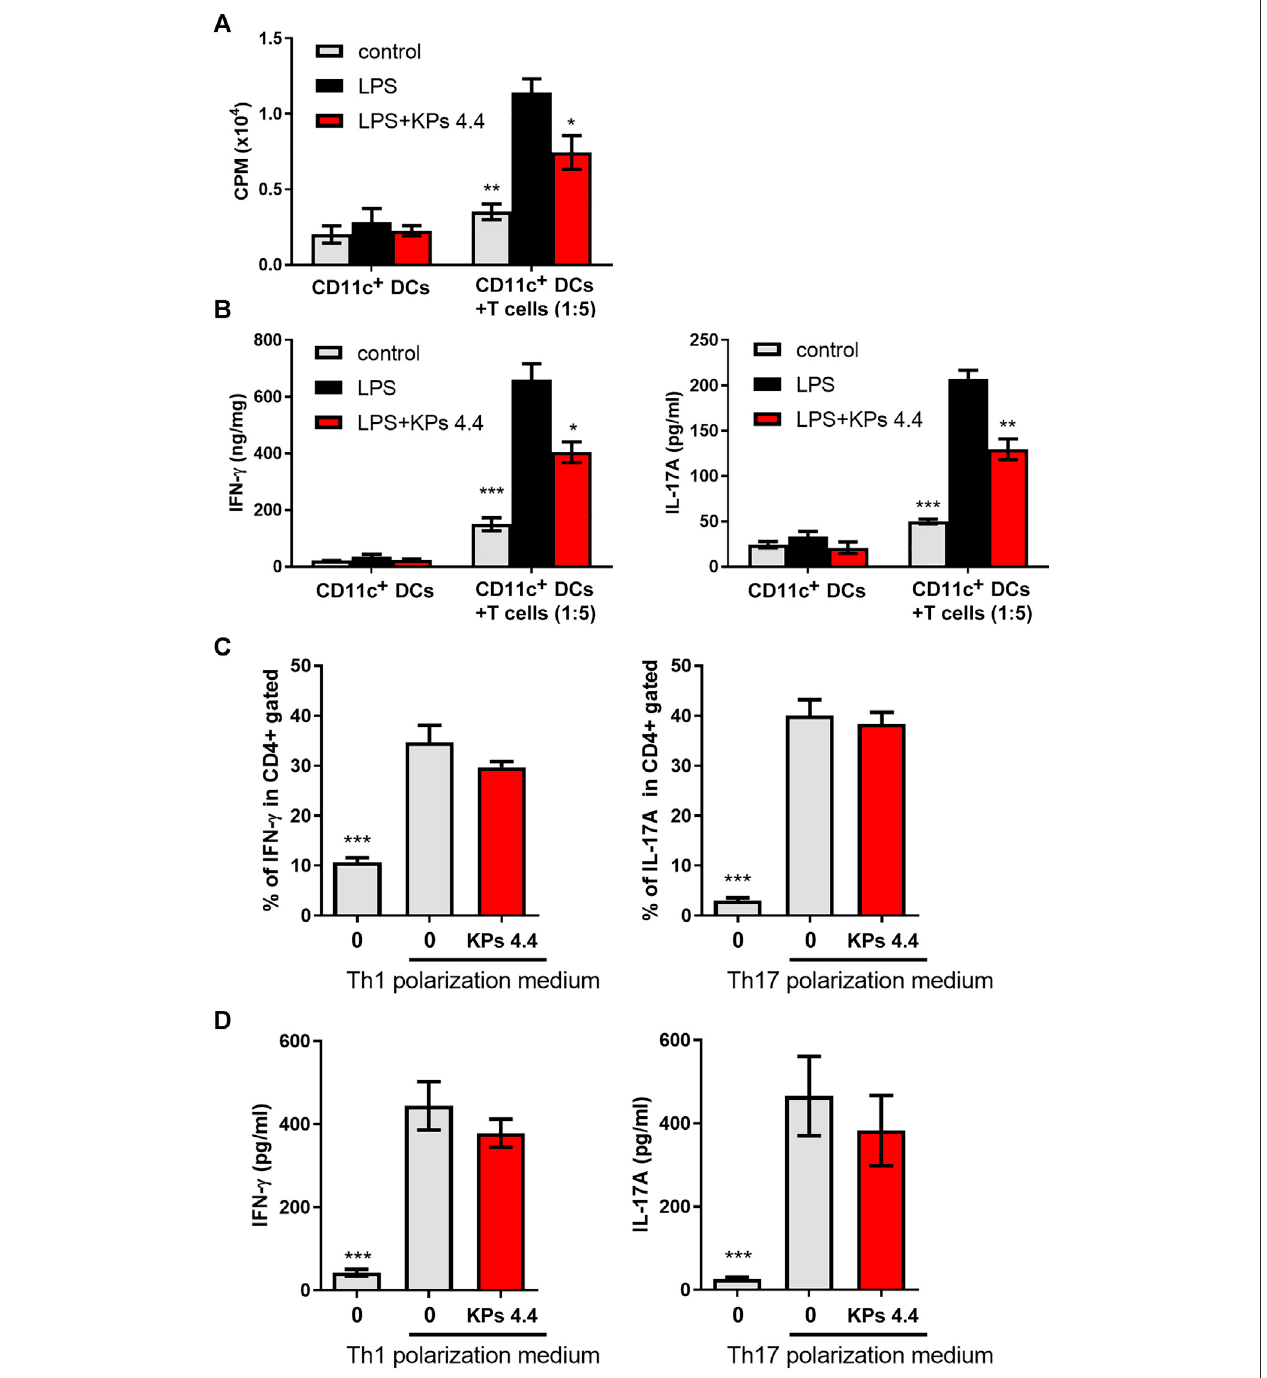
FIGURE 2 | Effects of KPs on CD4 + T cells proliferation, LPS-stimulated BMDC cytokine production in vitro , and Th1 and Th17 differentiation in vitro . (A) OT-II- speci fi c CD4 + T cells were cocultured with BMDCs in the presence of OVA and LPS. KPs were added at a concentration of 4.4 mg/ml at the beginning of the induction. After3 daysofculture,thechangesinTcellproliferationviathe 3 H-TdRincorporationassaywerequanti fi edincountsperminute(CPM)byliquidscintillationcounting. (B) The levels ofIFN- γ and IL1-7A inthesupernatantsofthe cocultures. The valuesare presented asthemean ± SEM(n (cid:1) 3). * p < 0.05;** p < 0.01; *** p < 0.001vs the LPSalonegroup,asdeterminedbyone-wayANOVAwithDunnett ’ stest. (C) NaïveCD4 + TcellswereculturedinTh1-orTh17-polarizingconditionedmedium.KPswere added at a concentration of 4.4 mg/ml at the beginning of induction. Bar graphs showing the percentages of CD4 + T cells expressing IFN- γ and IL-17A, as determined by fl owcytometry. (D) ThelevelsofIFN- γ and IL-17Aproduced underTh1-orTh17-polarizing conditions wereexaminedwithELISAkits. Thedataareexpressed asthe mean ± SEM (n (cid:1) 3). *** p < 0.001 compared to the LPS-stimulated group without KPs treatment, as determined by one-way ANOVA with Dunnett ’ s test.